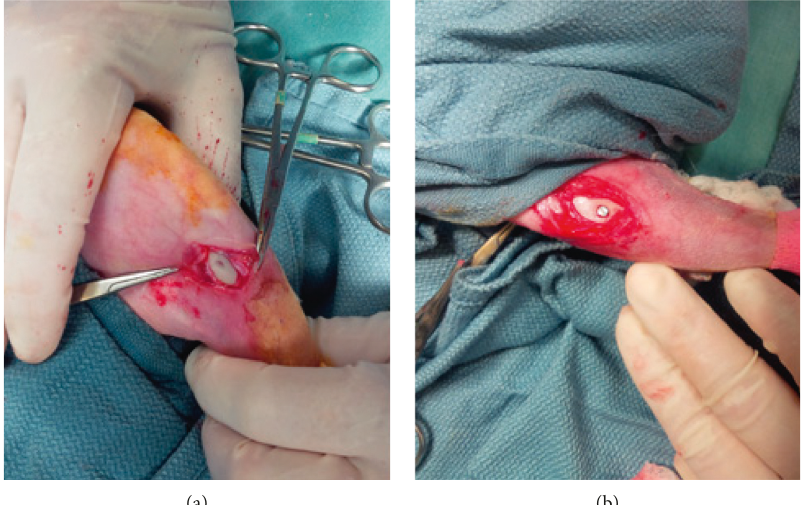
Figure 2: Cranial medial surgical approach parallel to the tibial crest. (a) Slow-rotating drill used to create pilot holes perpendicular to the bone crest. (b) SIT implants were pressed to fit into place until flush with bone crest. Control implants were screwed into place (not